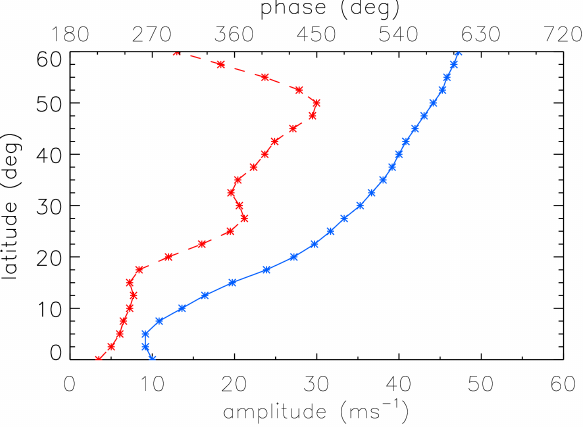
Figure 10. Evolutions of (red) amplitude and (blue) phase of oscil- lation with latitude. The asterisks represent the fitted values.